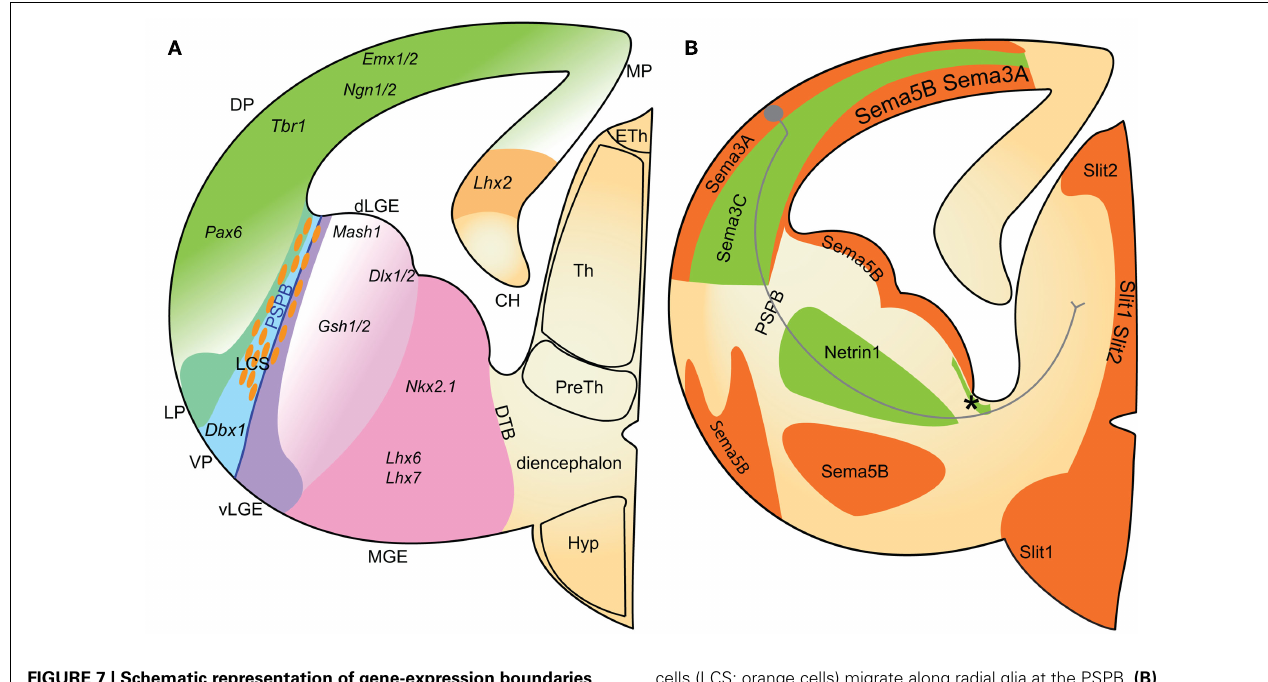
FIGURE 7 | Schematic representation of gene-expression boundaries in the developing telencephalon (A) and the expression patterns of identified axon guidance cues in relation to corticothalamic axons (B). (A) Early gene - expression boundaries subdivide the developing telencephalon into the pallium, in dorsal telencephalon, and the subpallium in the ventral telencephalon.The pallial – subpallial boundary lies between opposing gradients of Pax6 and Gsh2 expression in the pallium and subpallium respectively. Further subdivisions are generated with other discrete gene gradients. Dorsal pallium (DP) progenitors express Pax1, Emx1/2 , and Ngn1/2 (green gradient). Proximal to the cortical hem, the medial DP progenitors express Lhx2 (yellow).Ventral pallium (VP) progenitors express Dbx1 (aqua/turquoise).Within the subpallium, dorsal lateral ganglionic eminence (dLGE; pink gradient) progenitors express Mash1 and Dlx1/2 and have higher expression of Gsh1/2 than ventral LGE cells (light purple).The MGE can be distinguished from LGE by expression of Nkx2.1, Lhx6, and Lhx7 in the MGE (pink).The lateral cortical stream